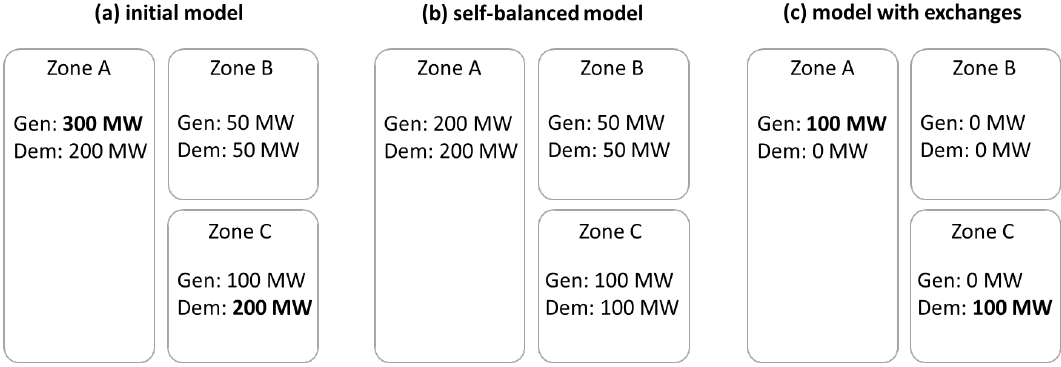
Figure 2. Initial model ( a ) decomposed into a balanced model ( b ) and model with exchanges ( c ) according to the PFC method [14]. Gen stands for generation and Dem —demand. A detailed description of the method can be found in References